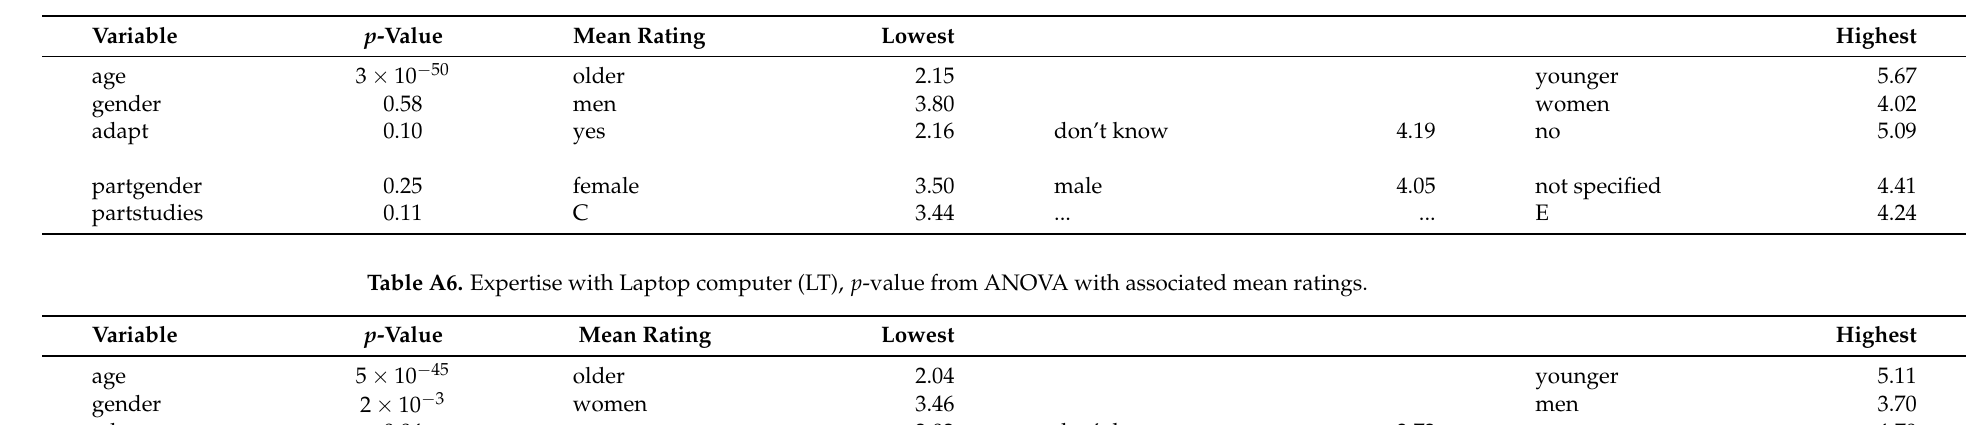
Table A5. Likelihood of use for Laptop computer (LT), p -value from ANOVA with associated mean ratings.